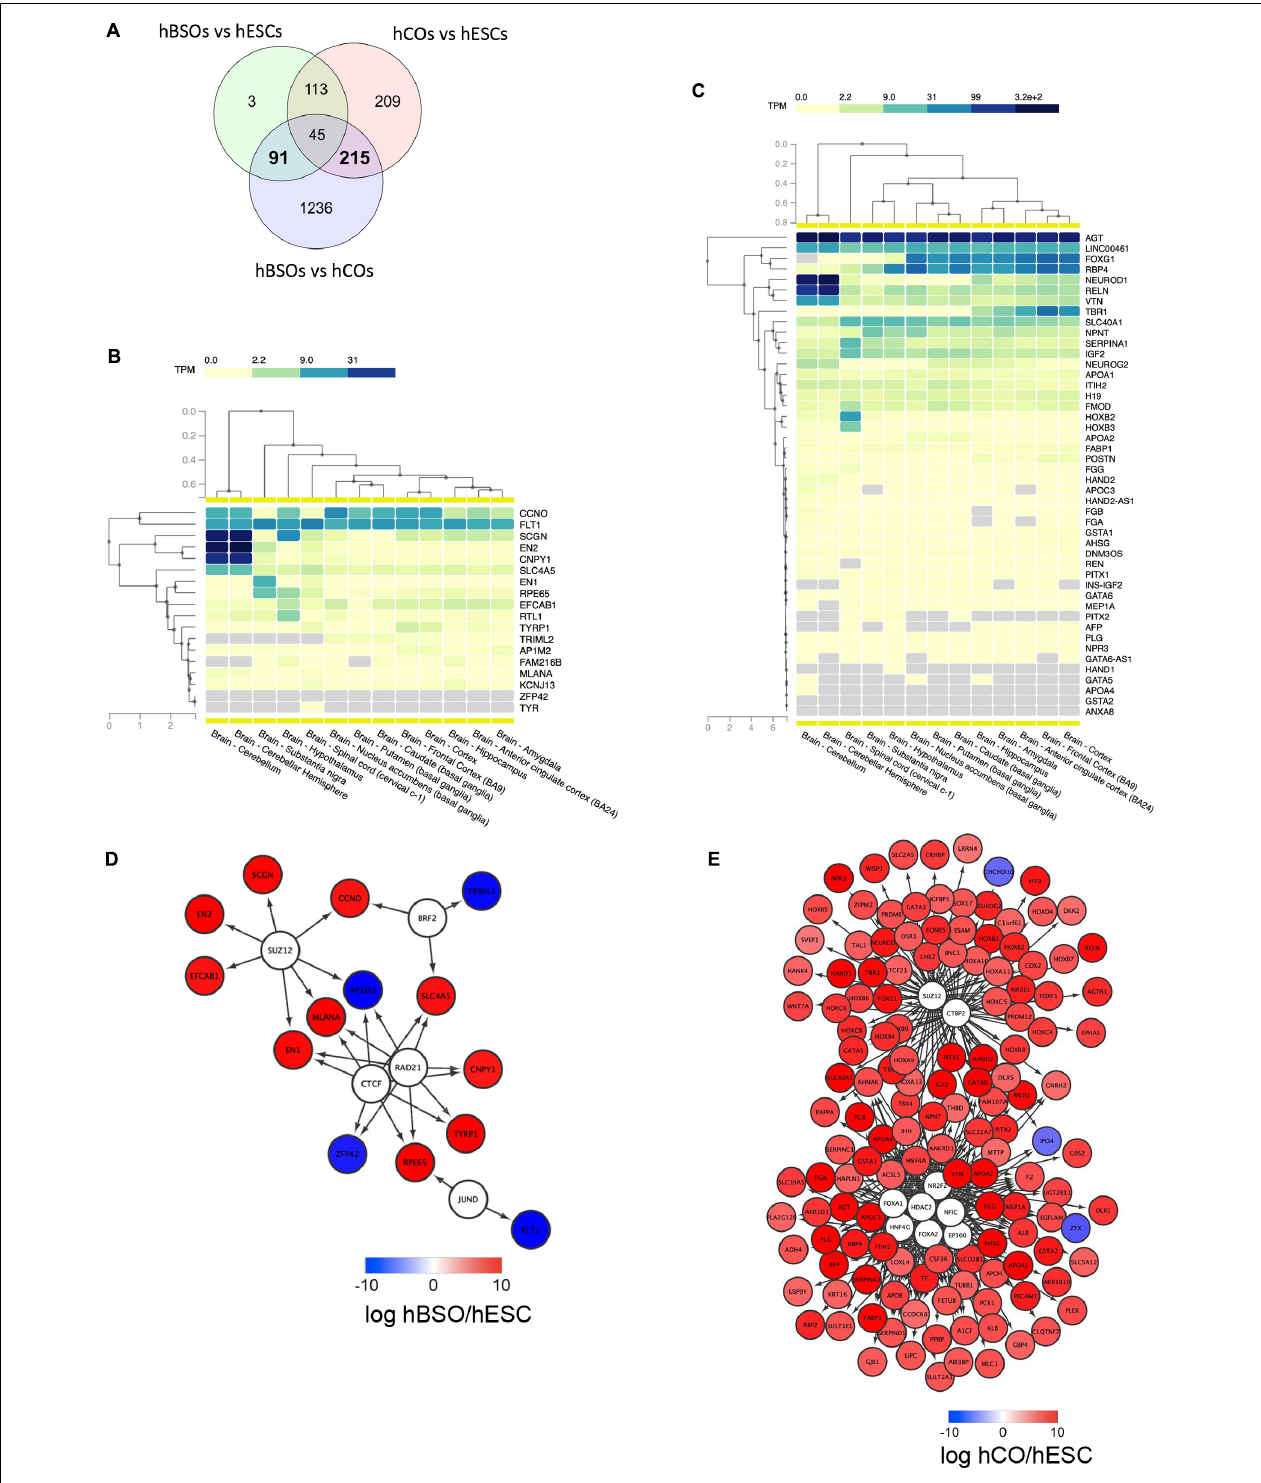
FIGURE 5 | RNA-seq transcriptomic analysis of 1-month old hBSOs from hESCs. (A) Venn diagrams of the number of genes differentially expressed between human brainstem organoids (hBSOs), human cerebral organoids (hCOs), and hESCs. (B) Clustering brain regions based on the expression of differentially expressed genes selective in hBSOs (FDR < 10%). (C) Clustering brain regions based on the expression of differentially expressed genes selective in hCOs (FDR < 3%). (D) Transcription factors that potentially regulate the differentially expressed genes in hBSOs. (E) Transcription factors that potentially regulate the differentially expressed genes in